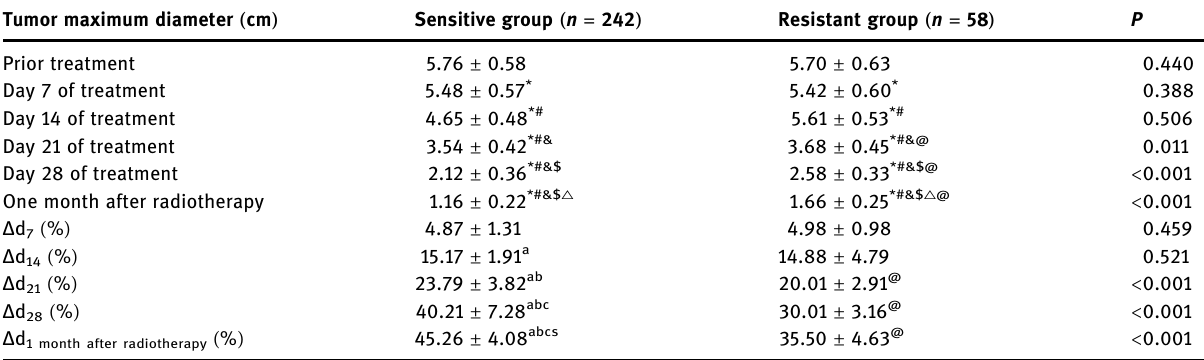
Tumor maximum diameter ( cm